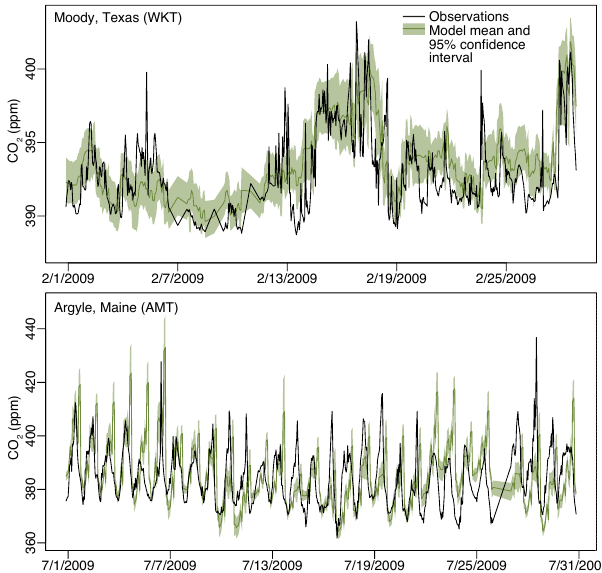
Figure 3. Hourly-averaged CO 2 measurements at (a) Moody, Texas, and (b) Argyle, Maine, compared against the CAM-LETKF model ensemble. Measurements are from the top inlet height at each location. In this figure, the model ensemble represents uncertainties due to atmospheric transport but not other errors (e.g., due to the fluxes and model